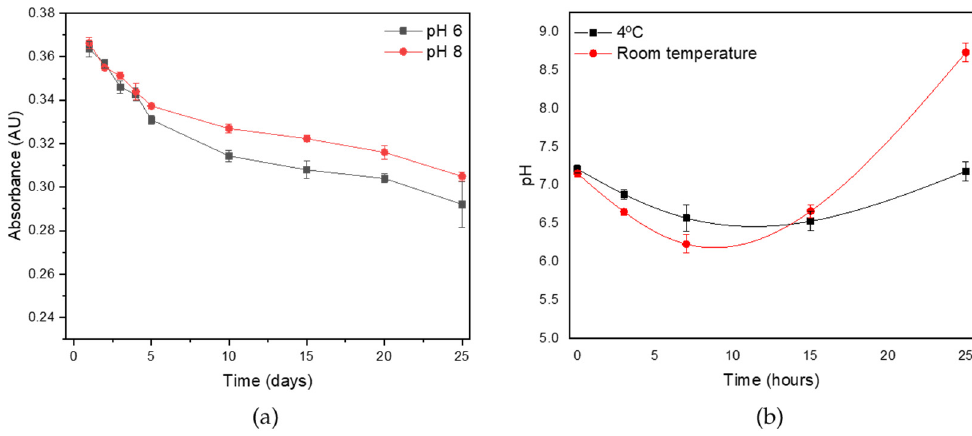
Figure 7. The lifetime of the prepared optical pH sensor ( a ). Application on tilapia fish stored at room temperature and 4 °C ( b ).